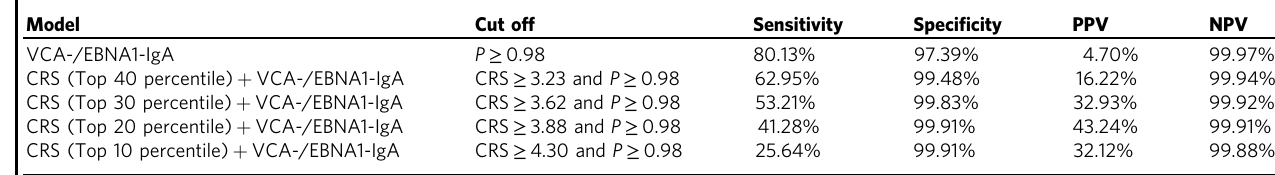
Table 3 Prediction accuracy of the serum VCA-/EBNA1-IgA antibody tests and the models combining serum EBV antibody levels and the comprehensive risk score with different cutoff values in the combined